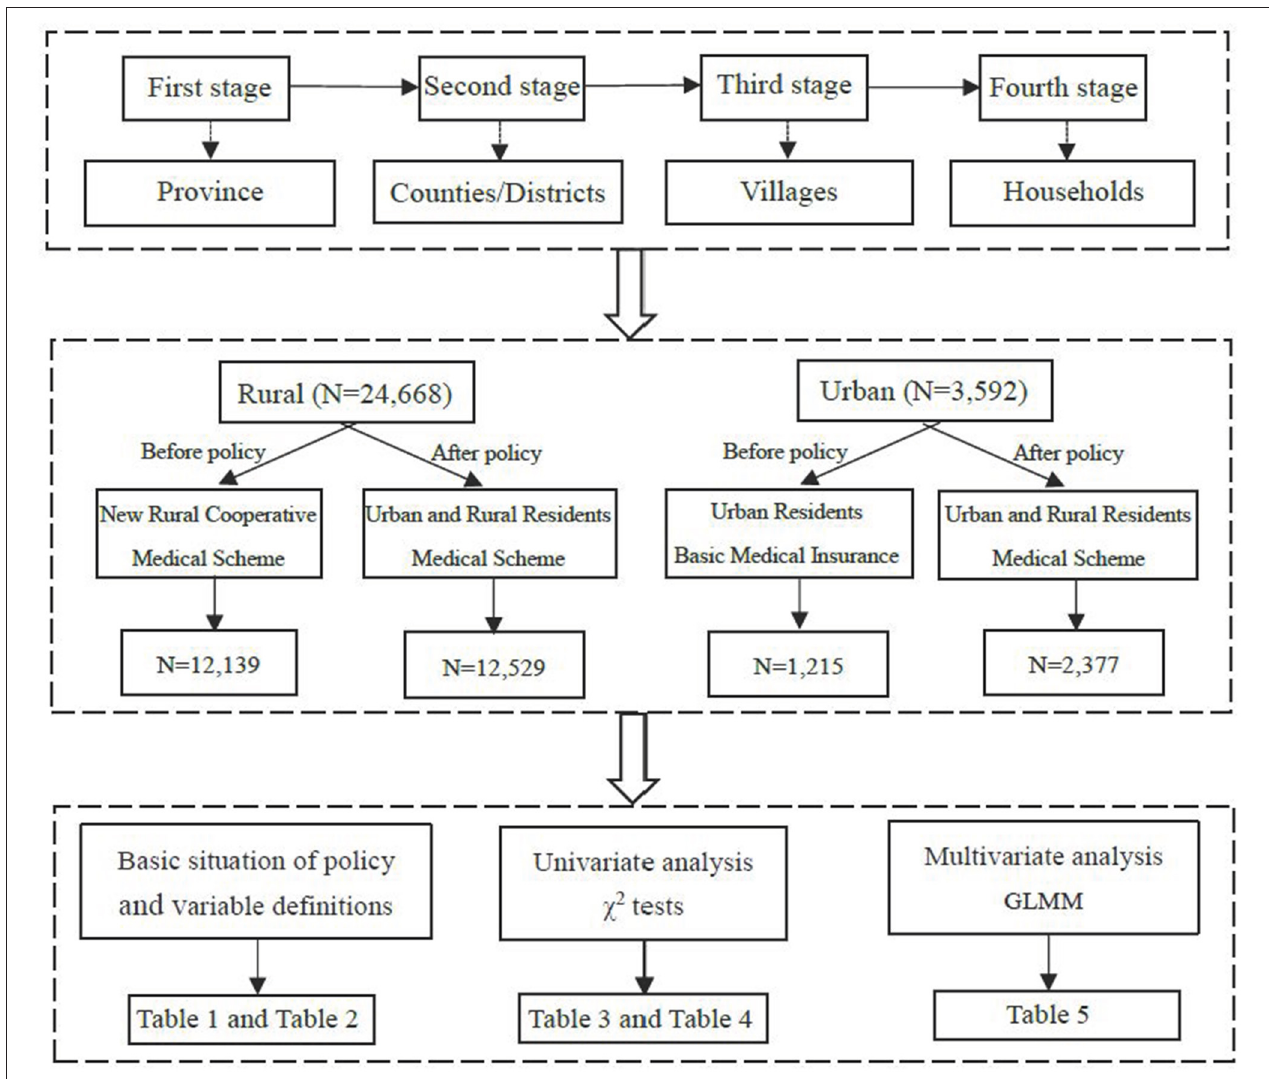
FIGURE 1 | Flowchart on the sample selecting process and analysis